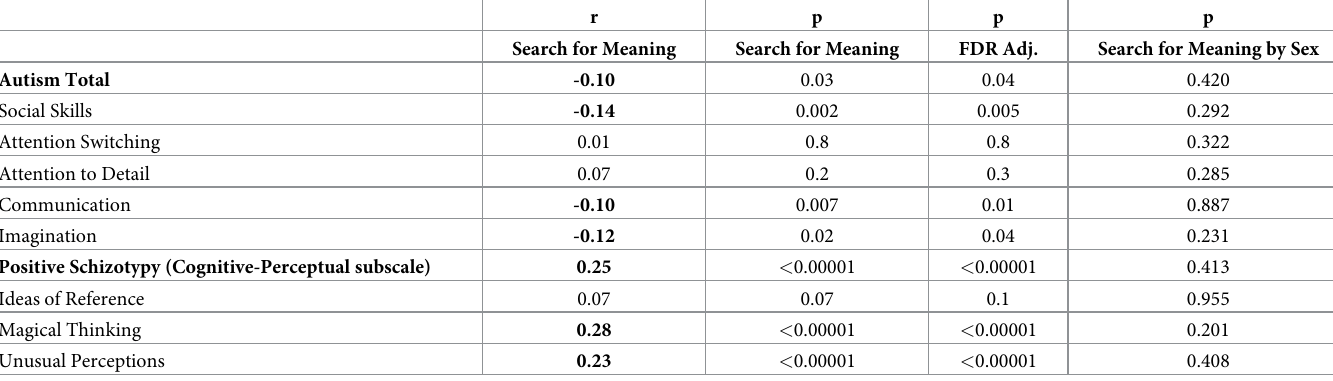
Table 4. Correlations of search for meaning with autism and schizotypal traits, and results from ANCOVAs testing for sex by trait interaction effects. r p p p Search for Meaning FDR